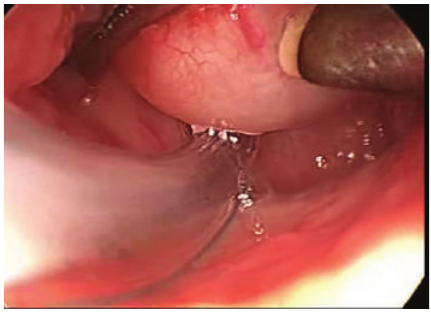
Figure 1: Contrast enhanced computed tomographic scan showing nonenhancing fluid filled lesion located at base of tongue of 12.2 × 13.4 mm.